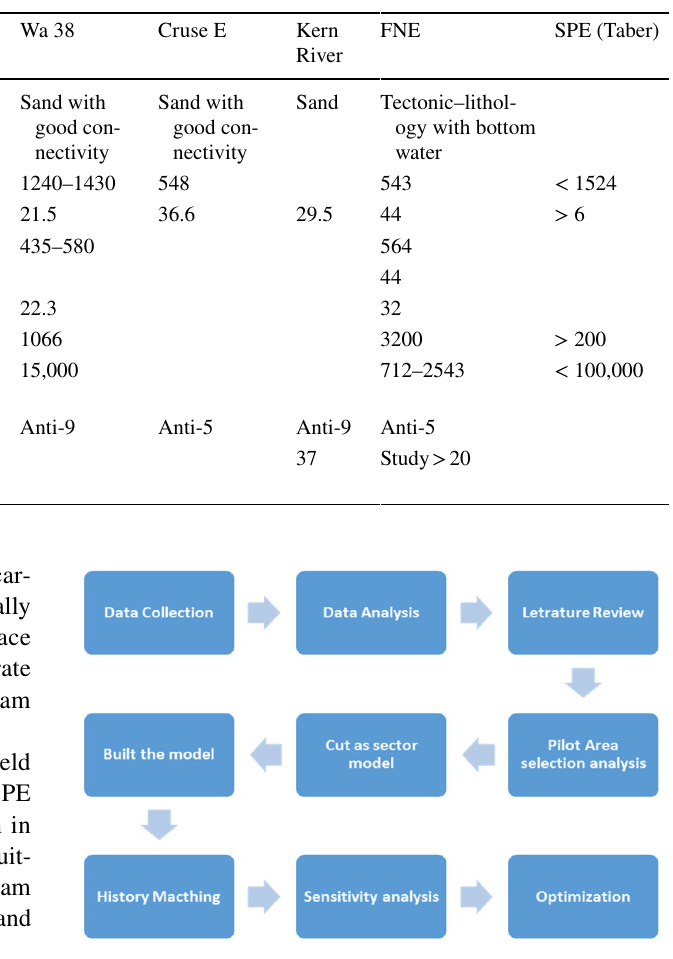
Fig. 2 The steps and workflow for this